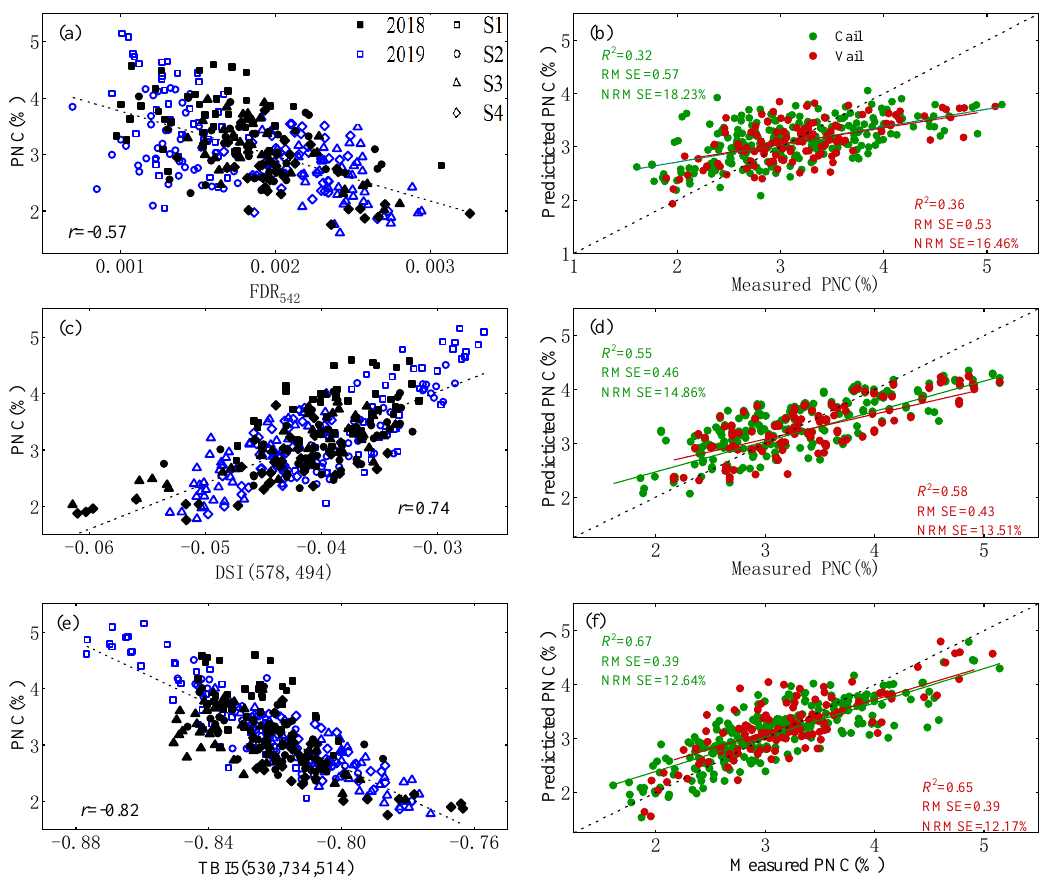
Figure 5. ( a , c , e ) Correlation of three optimal spectral indices of different dimensions with PNC over multiple potato-growth periods. ( b , d , f ) Optimal spectral indices for estimating PNC over multiple potato-growth periods.